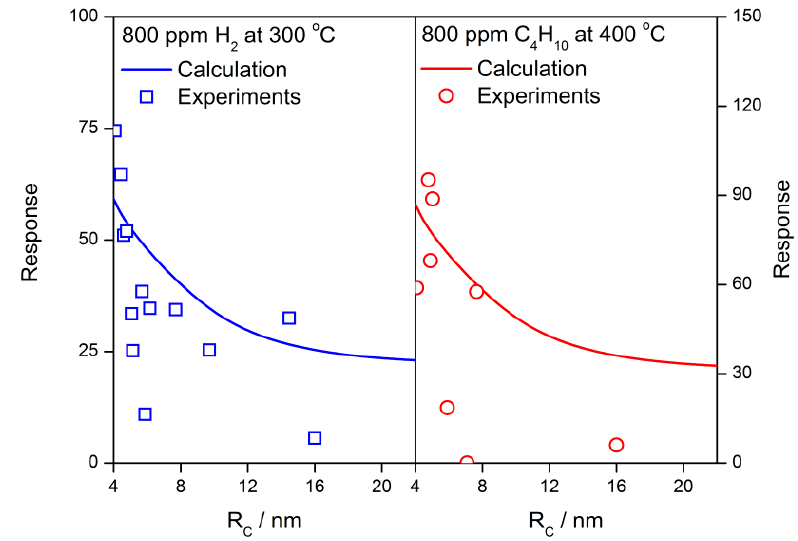
Figure 15. The grain size effects of calculation results and experimental response of the SnO 2 gas sensors to 800 ppm H 2 at 300 °C and 800 ppm C 4 H 10 at 400 °C, which are extracted from C. Xu’s work [43].